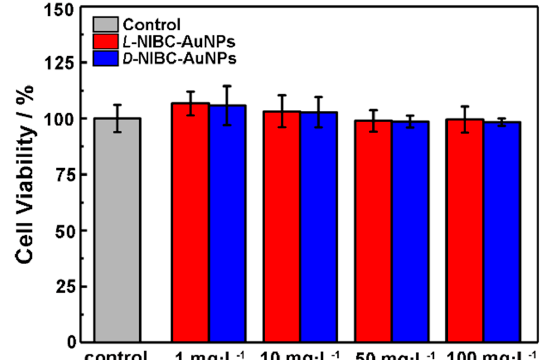
Figure 5. Viabilities of INS-1 cells after co-incubated with L -NIBC-AuNPs (red) or D -NIBC-AuNPs for 24 h with different concentrations from 1 to 100 mg·L − 1 , respectively. Data represented as mean ± SD ( n = 3).